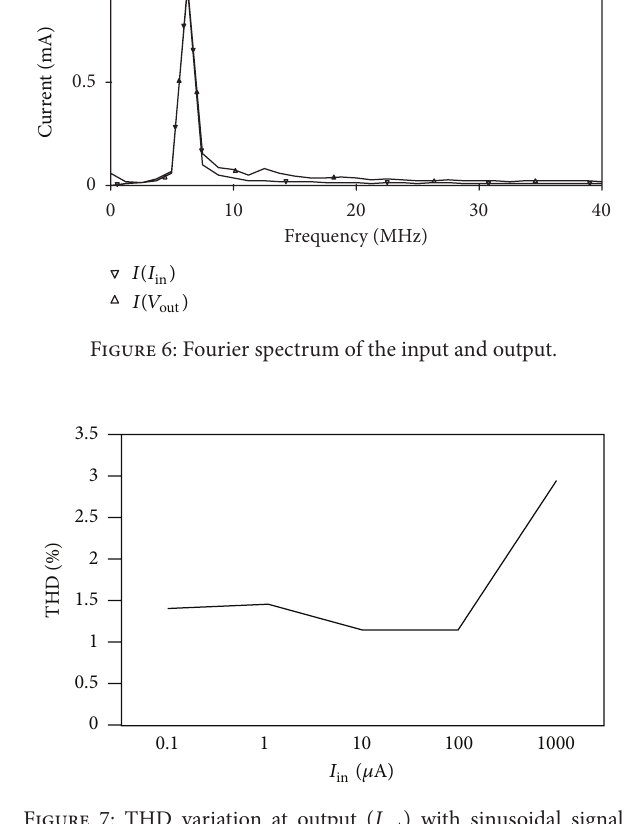
) with sinusoidal signal out